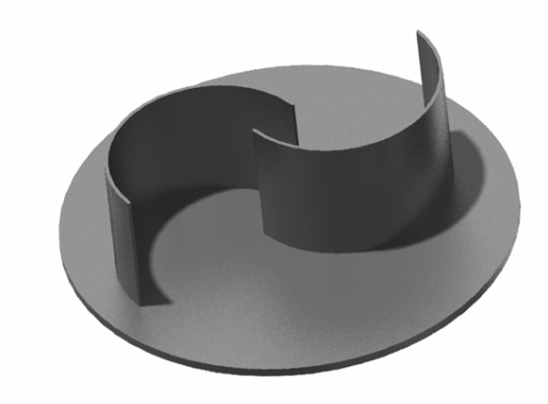
Figure 1: Model of the investigated Classical Savonius wind turbine (due to its symmetry only a half of turbine is presented).